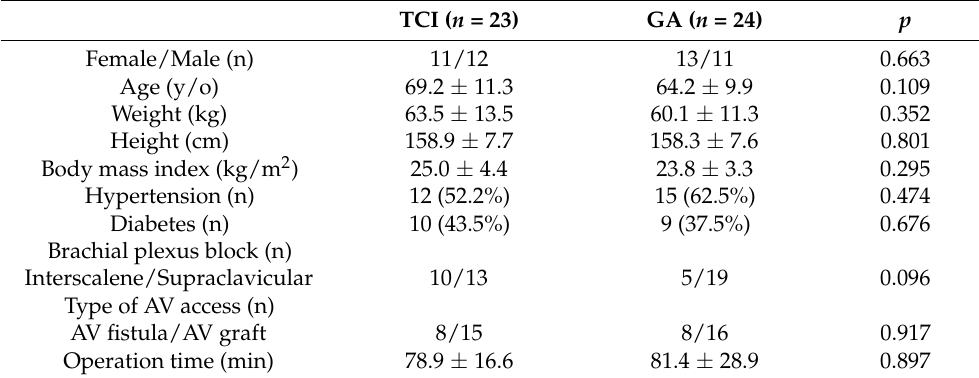
Figure 1. Subject enrollment flowchart. TCI = Propofol target-controlled infusion. GA = General anesthesia. Table 1. Patient characteristics.